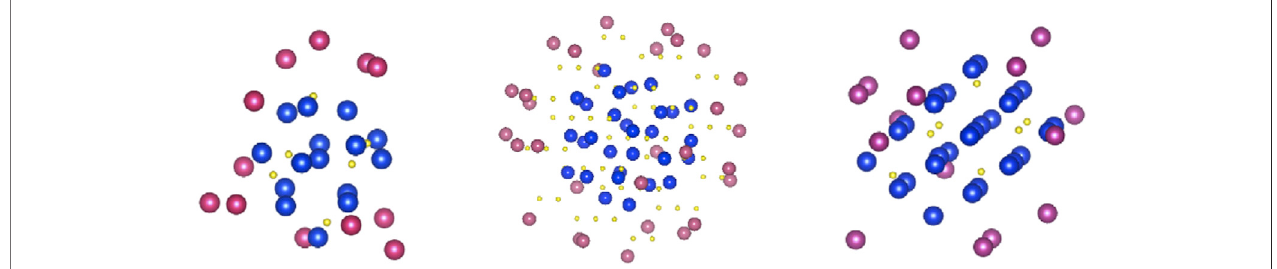
FIGURE 6 | The stable con fi gurations of He-H-V clusters. The small yellow circles represent vacancies, pink ones represent hydrogen atoms, and blue ones represent helium atoms (Hayward and Deo,